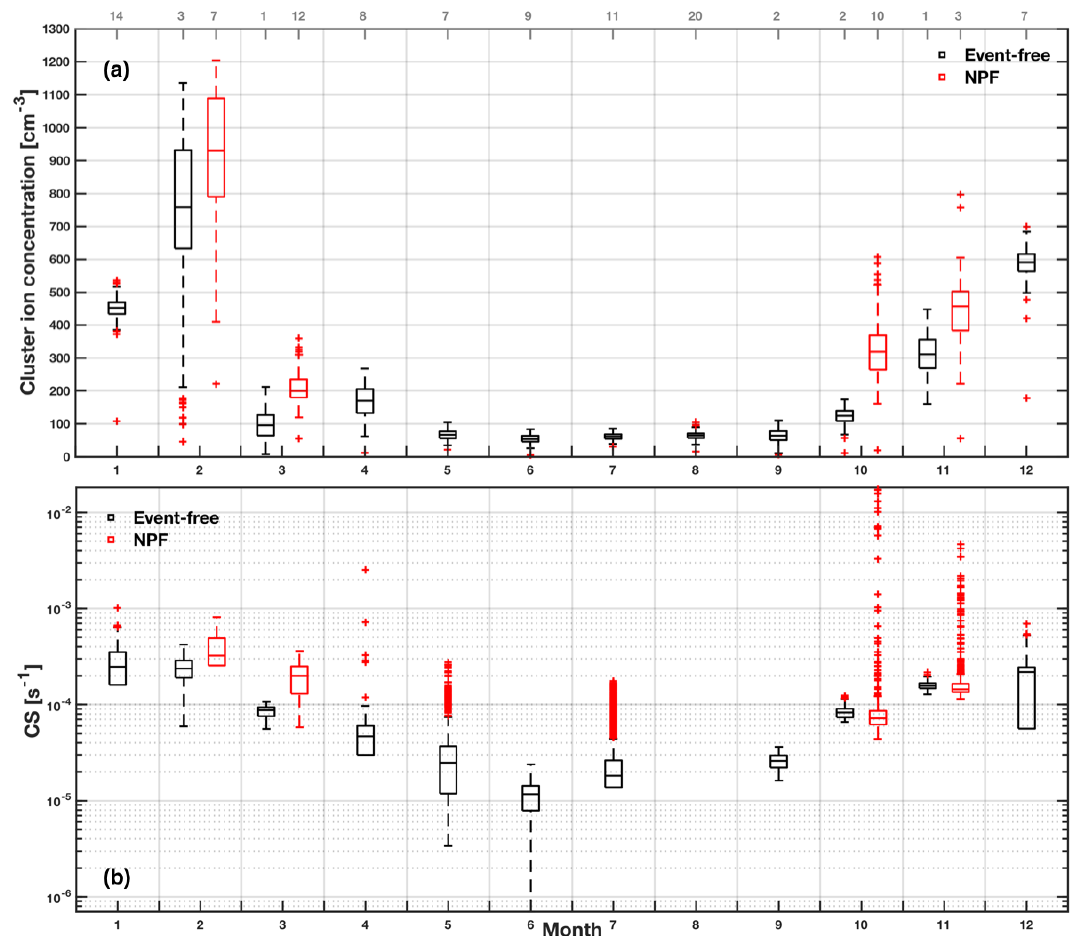
Figure 2. Seasonality in the median (a) cluster ion (0.9–1.9nm) concentration and (b) condensation sink (CS). Tops and bottoms of the boxes are the 75th and 25th percentiles of the median daily values in 10min time resolution, with bars in the middle showing the 50th percentiles. Whiskers represent spans of the interquartile ranges multiplied by 1.5. Cluster ion concentrations or CS on NPF days shown in red and on event-free days in black. Event-free conditions were restricted to days on which there was no NPF, cloud activation, wind-induced events, or contamination as well as other anomalies altering the ion concentration in the cluster band. The numbers of days classified as either event-free or NPF are displayed at the top of panel (a) in grey. No CS was obtained in August due to the lack of measured temperature and pressure data from the station